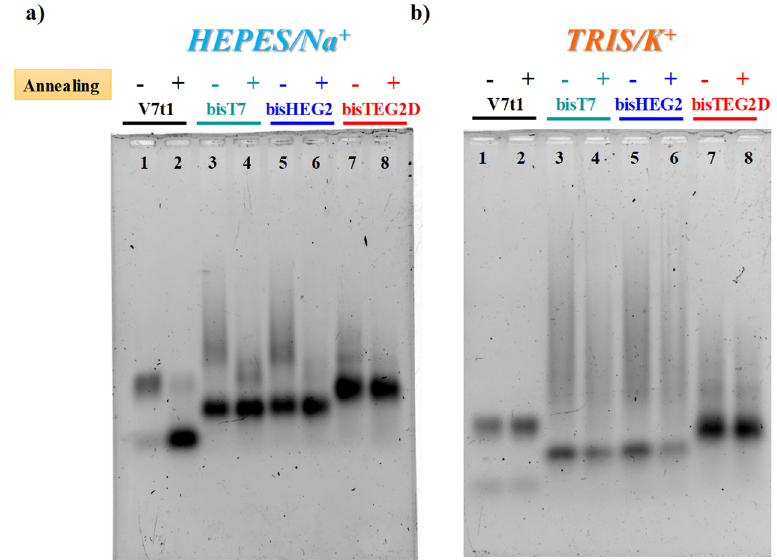
Figure 1. The 2% agarose gel electrophoresis under native conditions of V7t1 and its covalent dimeric analogues (here indicated as bisT7 , bisHEG2 , bisTEG2D) in both not-annealed (N.A.) ( − ) and annealed (A.) (+) form at 4 μ M concentration in the selected HEPES/Na + ( a ) and TRIS/K + ( b ) buffer solutions. Gels were run at constant 60 V at r.t. for 2 h in Tris-Borate-EDTA (TBE) 1X as running buffer. With respect to bisV7t1T7 and bisV7t1HEG2 , bisV7t1TEG2D behaved differently: its N.A. and